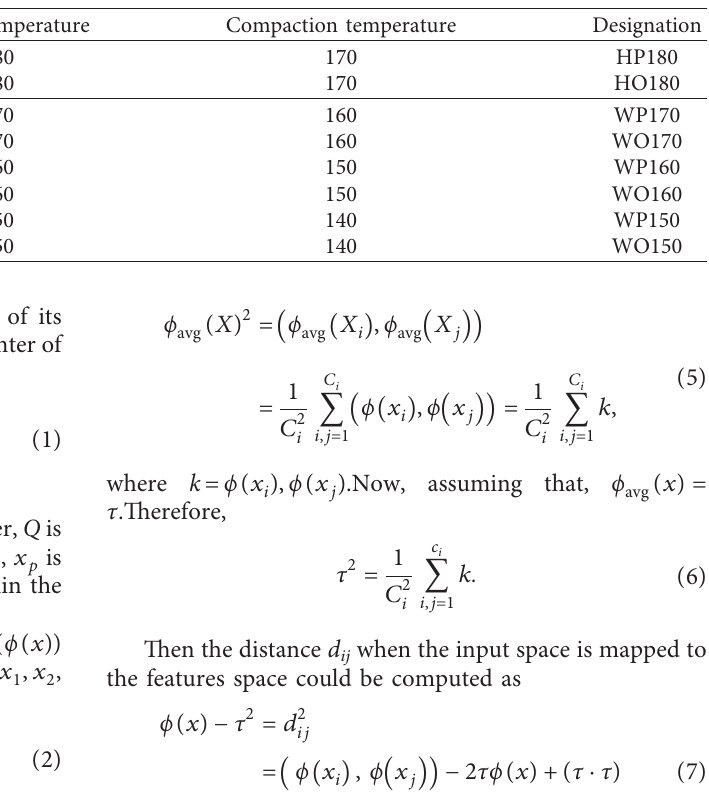
Table 2: Mixing and compaction temperature of asphalt